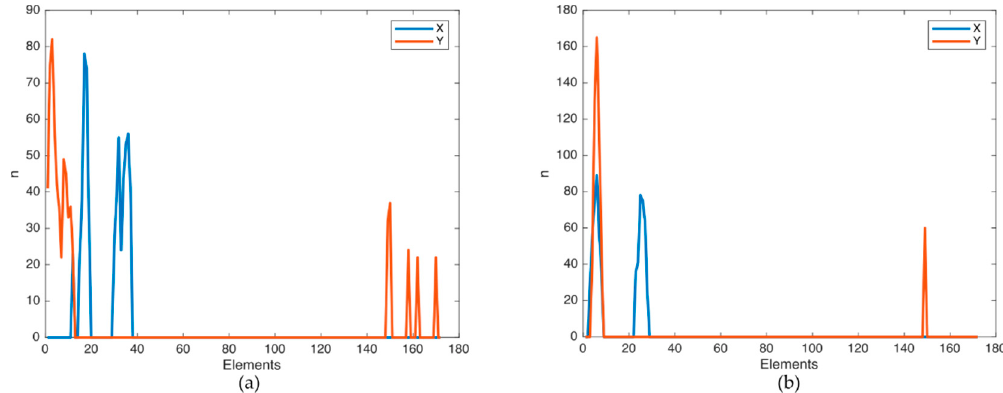
Figure 7. Histograms of the X and Y axes for a di ff erent angle of rotation: ( a ) Original angle of 0 degrees; ( b ) Angle of 4.3 degrees.